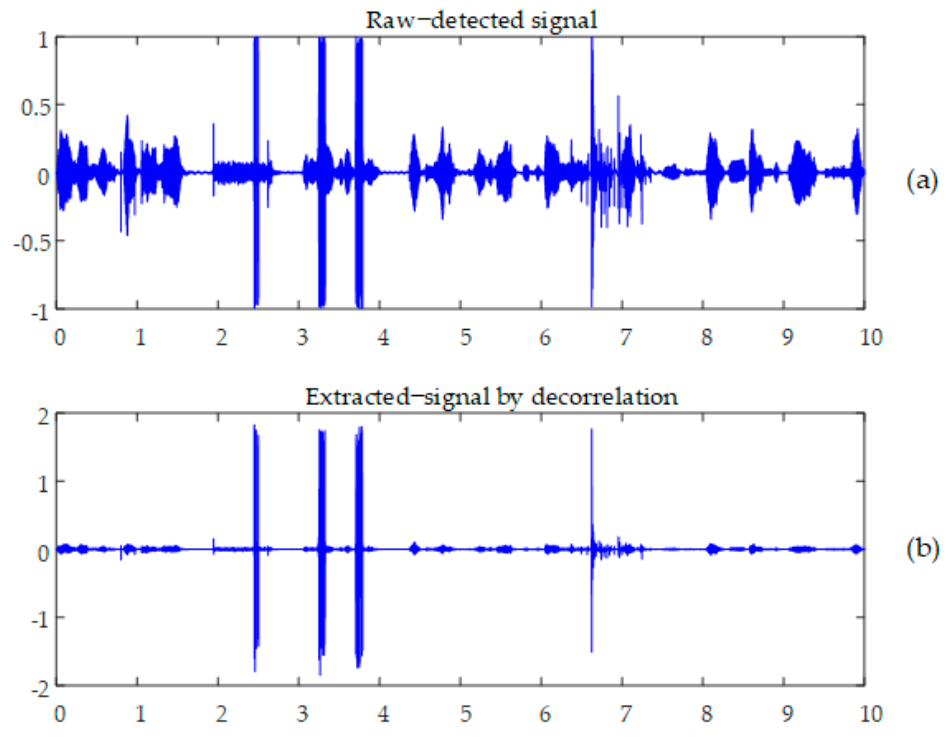
Figure 5. Comparison of ( a ) raw-detected signal and ( b ) extracted-signal by decorrelation.